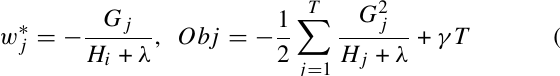
From Sect. “Literature Review”, 186,630 auto loan records into a training set and test set in a 7:3 ratio, as shown in Table 9. (2) Parameter optimization To improve the execution and classification performance of the XGBoost model, a parameter adjustment of the XGBoost model is required. For this, the PSO algorithm is used to optimize the parameters of the XGBoost model. When forming the XGBoost model, three parameters need to be adjusted, i.e., learning rate (learning_rate), maximum depth of the tree (max_depth), and the sample weight of min- imum leaf node (min_child_depth), to improve the accuracy of the XGBoost model. The steps are detailed as